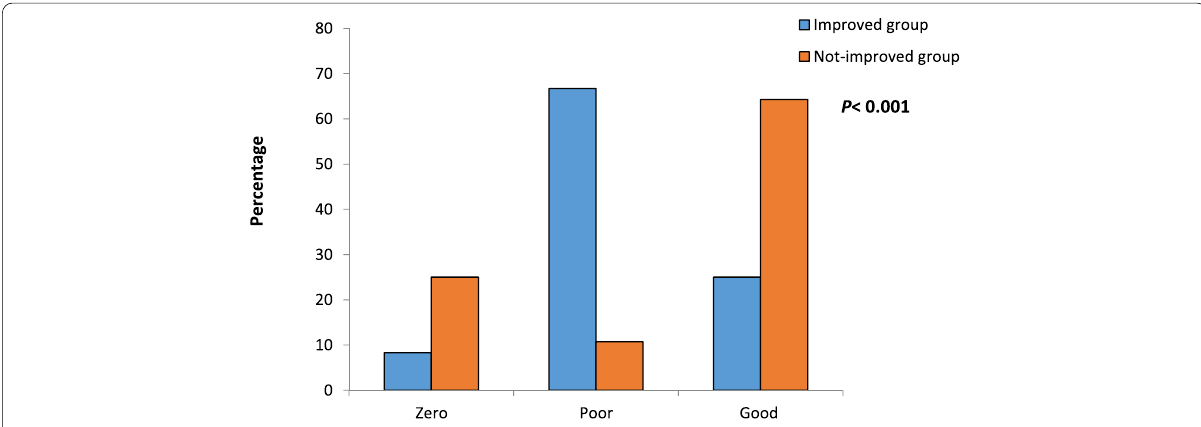
Fig. 2 Speech discrimination based on outcome of studied patients